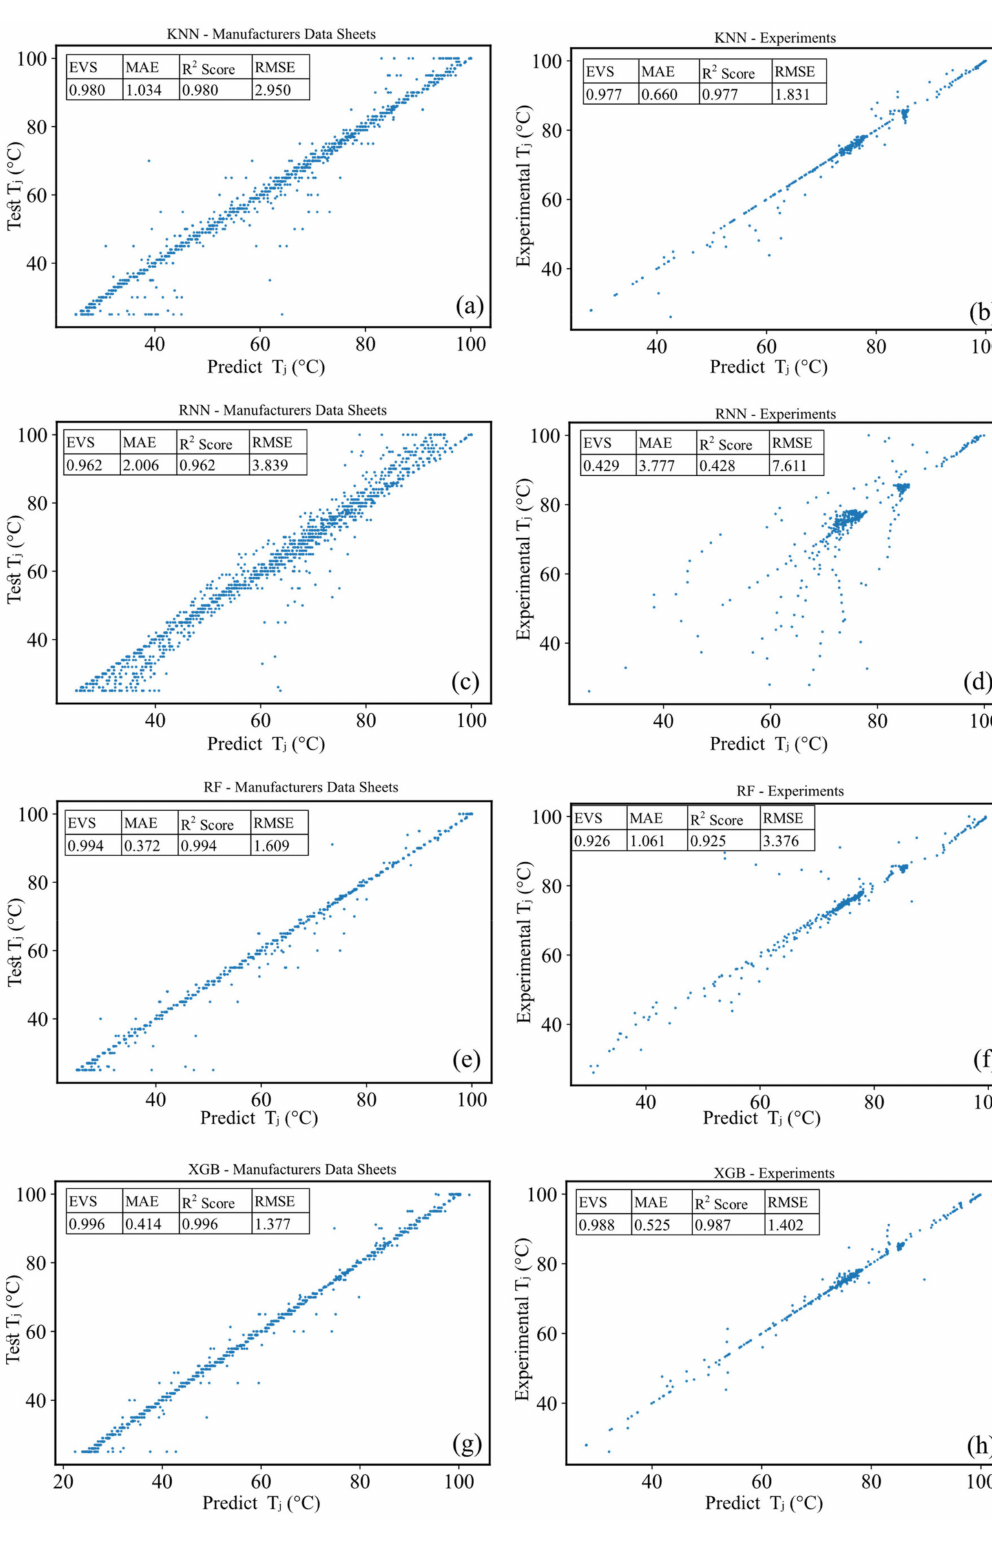
Figure 5. ( a ) KNN, ( c ) RNN, ( e ) Rf, and ( g ) XGB predictions based on package data sheets. ( b ) KNN, ( d ) RNN, ( f ) RF, and ( h ) XGB predictions based on experimental inputs. EVS, MAE, R 2 score, and RMSE for each case are provided in a